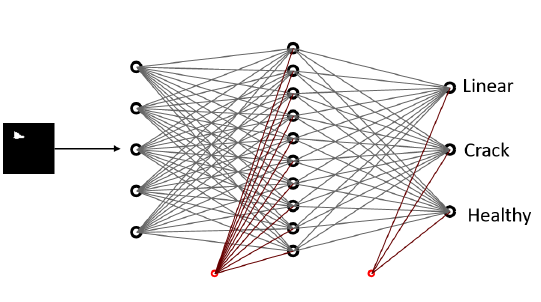
Figure 5. Architecture of the direct spot classifier: the input image is provided as input for the neural network.